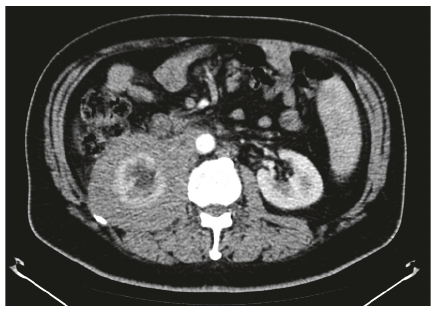
Figure 1: Preoperative computed tomography (CT) scan showing a right renal mass.